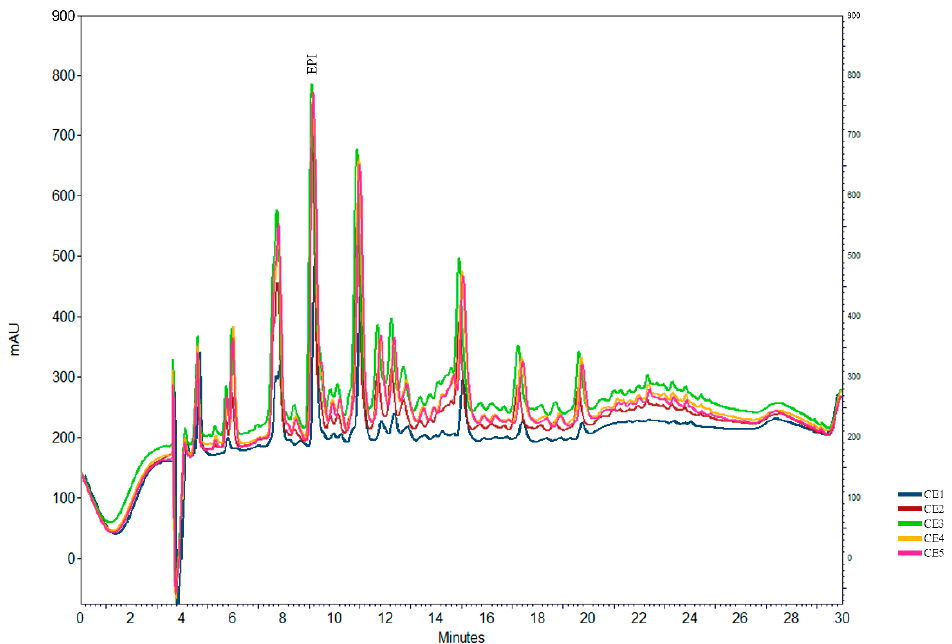
Figure 1. Chromatographic profile at 210 nm of the purified extract of Monteverdia ilicifolia . Chromatographic conditions: column Phenomenex ® , Gemini C-18 (250 mm × 4.6 mm i.d., 5 µ m), SecurityGuard (RP-cartridge) (20 mm × 4.6 mm i.d., 5 µ m). Mobile phase: water (formic acid 0.1%) A and acetonitrile (formic acid 0.1%) B: 0 min 18% B; 13 min 25% B; 16 min 34% B; 20 min 42% B; 23 min